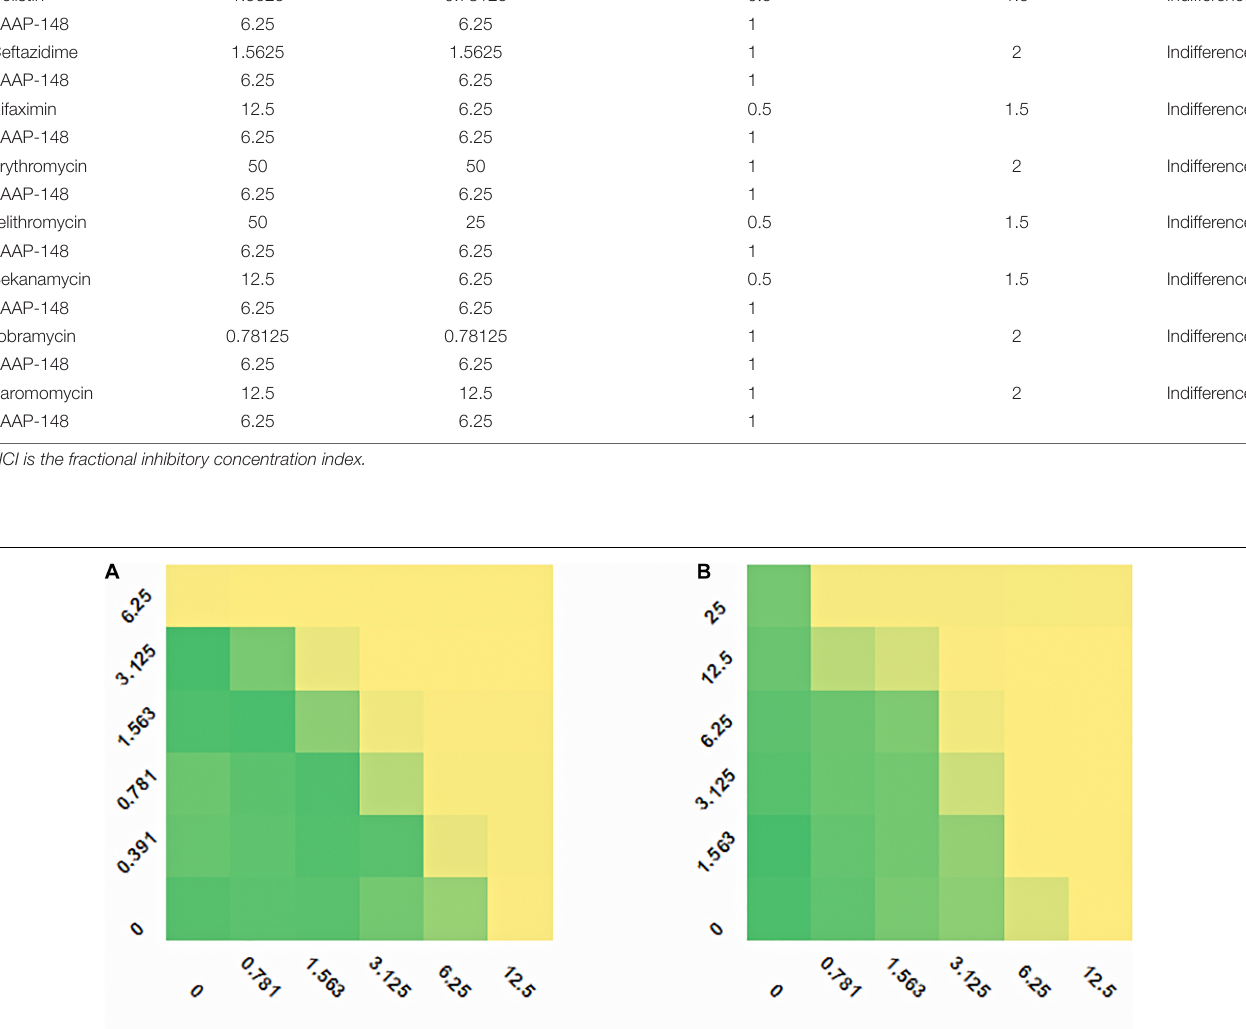
Frontiers in Microbiology |